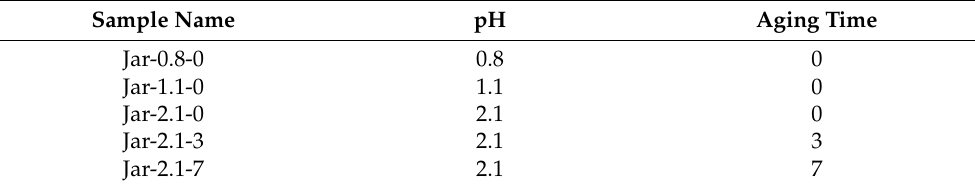
Table 1. List of samples with their synthesis conditions studied in this work.